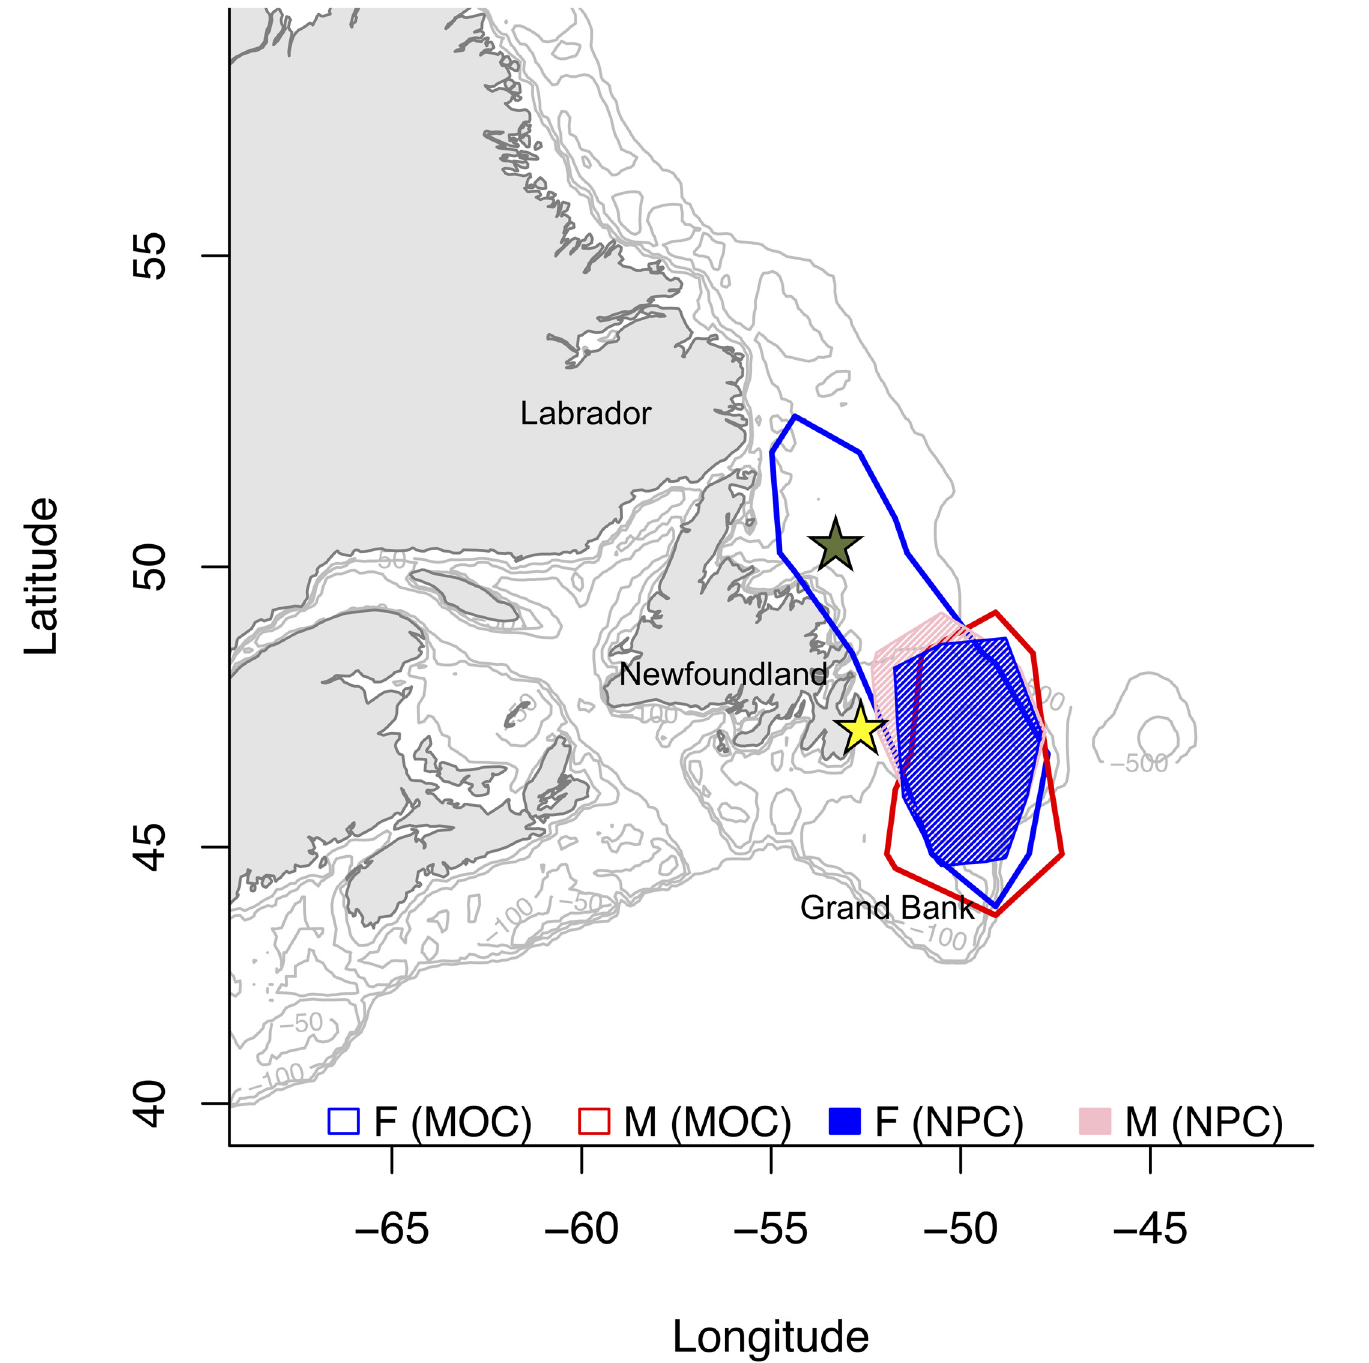
Fig 1. Core foraging areas (50% kernal contours) of female (blue) and male (red) murres during MOC (14 F, 8 M) and NPC (12 F, 9 M). Colony locations are indicated by a yellow (Gull I) and green star (Funk I). Depths between isobaths are 100 m. Bathymetry data were obtained online from the GEBCO Digital Atlas (GEBCO one-minute grid, ver. 2,